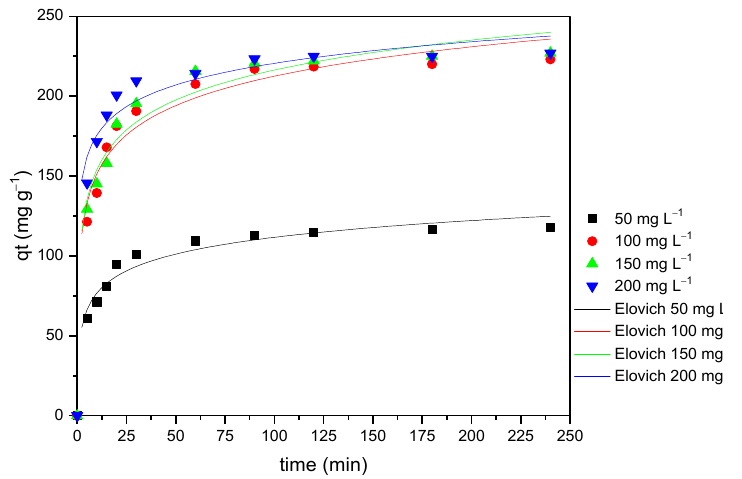
Figure 6. Elovich model fitting to experimental data for adsorption of MB on CXTi synthesised in this study, at initial concentrations of 50, 100, 150 and 200 mg L − 1 (T = 23 °C, dose = 0.01 g mL − 1 ).